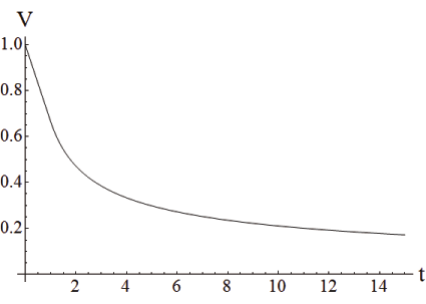
Figure 6. Graph of the volume remaining, V ( t ), plotted against drainage time t .